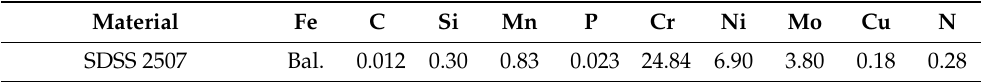
Table 1. Chemical composition of the 25Cr-7Ni super duplex stainless steel (wt.%).